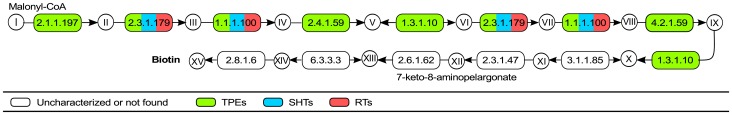
Biosynthesis of biotin.
Metabolites - I: malonyl-CoA; II: malonyl-CoA methyl ester; III: a 3-oxo-glutaryl-[acp] methyl ester; IV: a 3-hydroxyglutaryl-[acp] methyl ester; V: an enoylglutaryl-[acp] methyl ester; VI: a glutaryl-[acp] methyl ester; VII: a 3-oxo-pimelyl-[acp] methyl ester; VIII: a 3-hydroxypimelyl-[acp] methyl ester; IX: an enoylpimelyl-[acp] methyl ester; X: a pimelyl-[acp] methyl ester; XI: a pimelyl-[acp]; XII: 7-keto-8-aminopelargonate; XIII: 7,8-diaminopelargonate; XIV: dethiobiotin; XV: biotin. Enzymes -
2.1.1.197: malonyl-CoA methyltransferase; 2.3.1.180: β-ketoacyl-acyl carrier protein synthase III; 1.1.1.100: 3-oxo-acyl-[acyl-carrier-protein] reductase; 2.4.1.59: 3-hydroxy-acyl-[acyl-carrier-protein] dehydratase; 1.3.1.10: enoyl-[acyl-carrier-protein] reductase; 2.3.1.41: β-ketoacyl-ACP synthase I; 3.1.1.85: pimeloyl-[acp] methyl ester esterase; 2.3.1.47: 8-amino-7-oxononanoate synthase; 2.6.1.62: 7,8-diaminopelargonic acid synthase; 6.3.3.3: dethiobiotin synthetase; 2.8.1.6: biotin synthase.